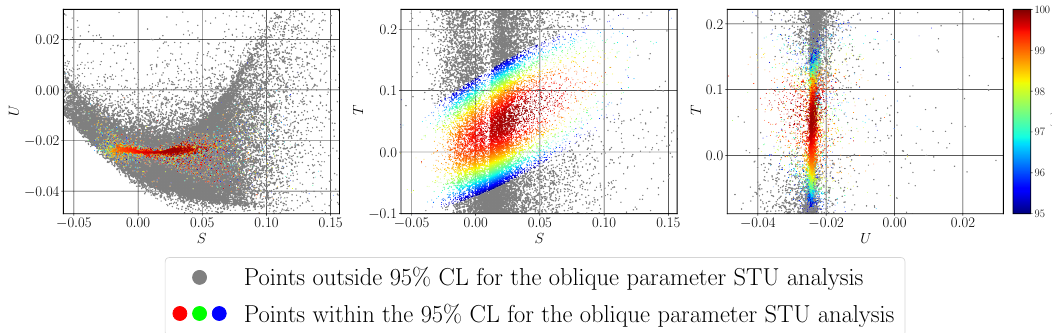
Figure 1 . STU electroweak precision observables for all sampled points. Only coloured points pass the STU analysis with a confidence level (CL) of, at least,